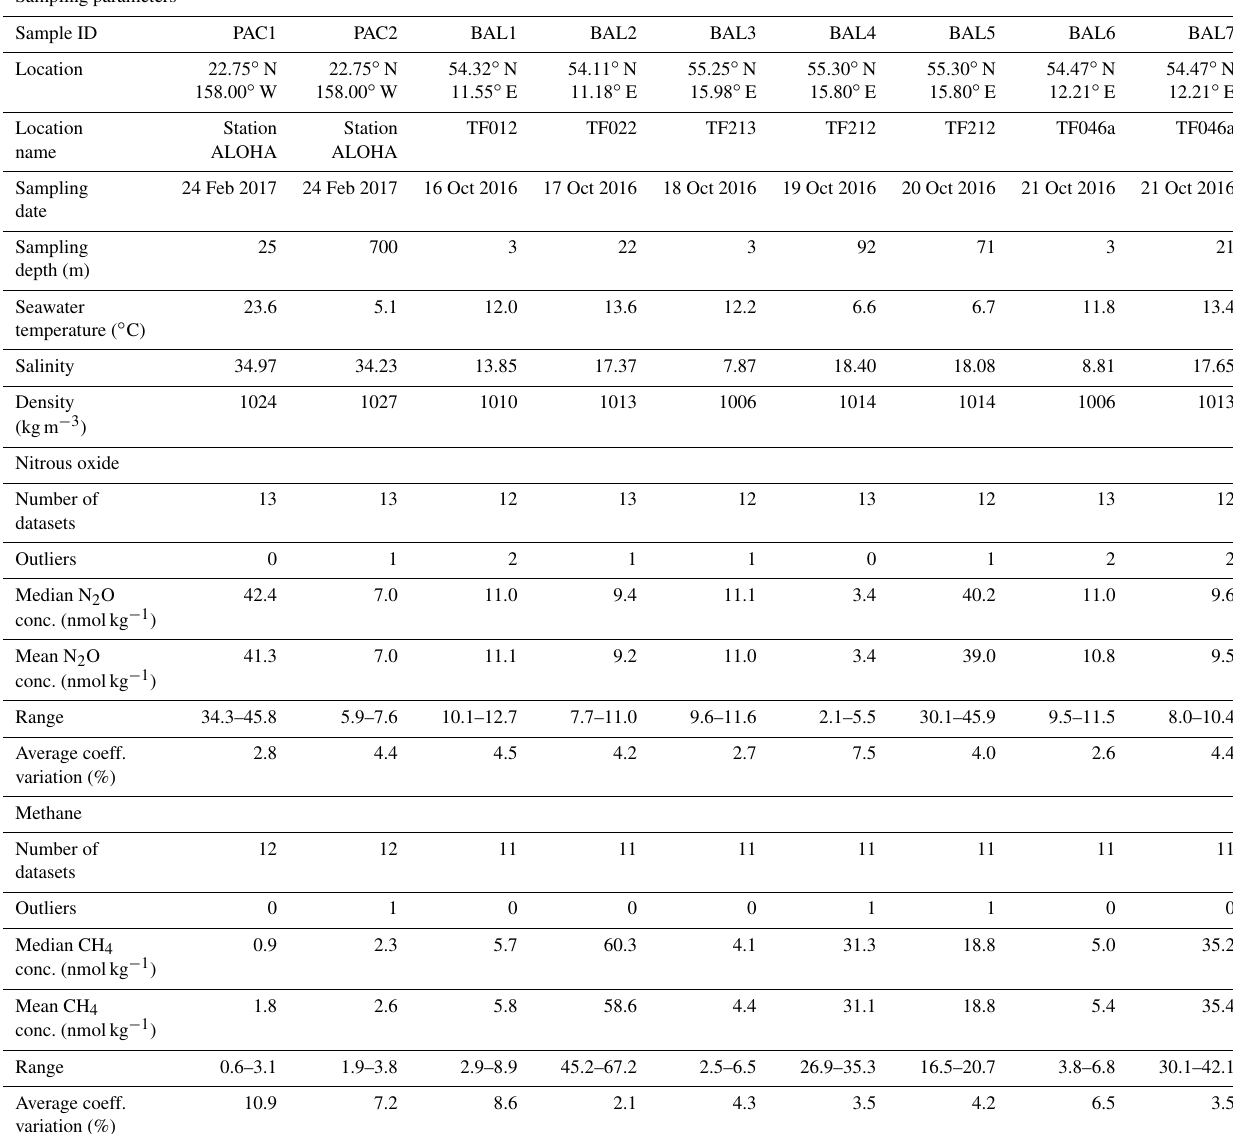
Table 2. Pertinent information for each batch of methane and nitrous oxide samples. This includes contextual hydrographic information, median and mean concentrations of methane and nitrous oxide, range, number of outliers, and the overall average coefficient of variation